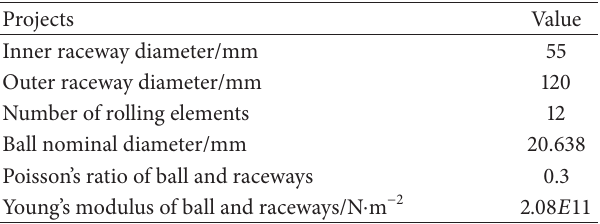
Table 1: Parameters of 7311B angular contact ball bearing.